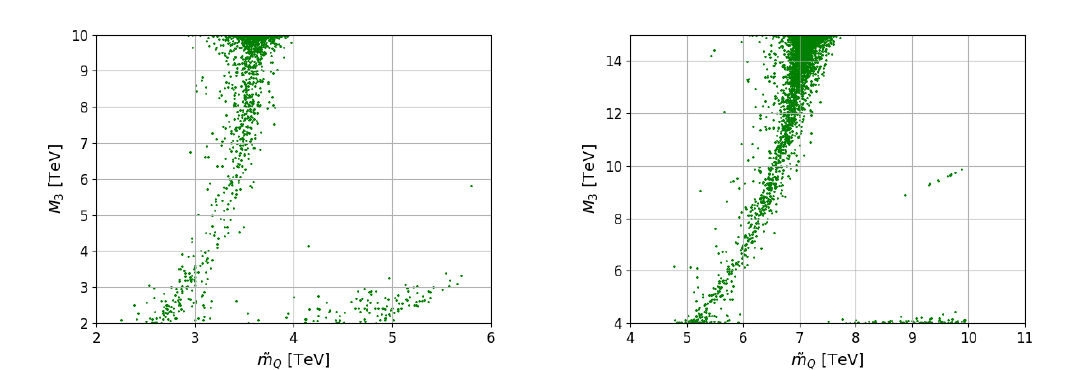
Figure 11 . Scatter plot of the squark and gluino masses for B ( K 0 into account the constraints de(cid:12)ned in section 2. Left: scenario A, Right: scenario C. The (cid:31) 2 cut in Scenario A has been relaxed to 14 to increase the density of points.